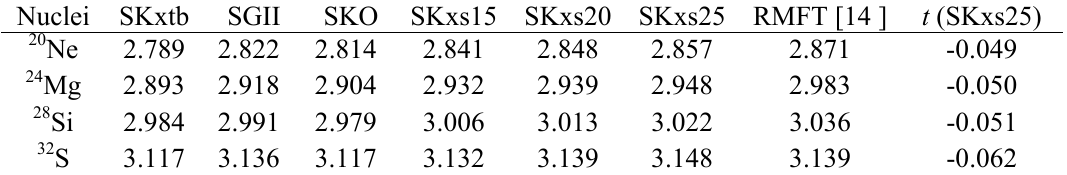
Table 4: Calculated neutron rms radii compared with RMFT results.